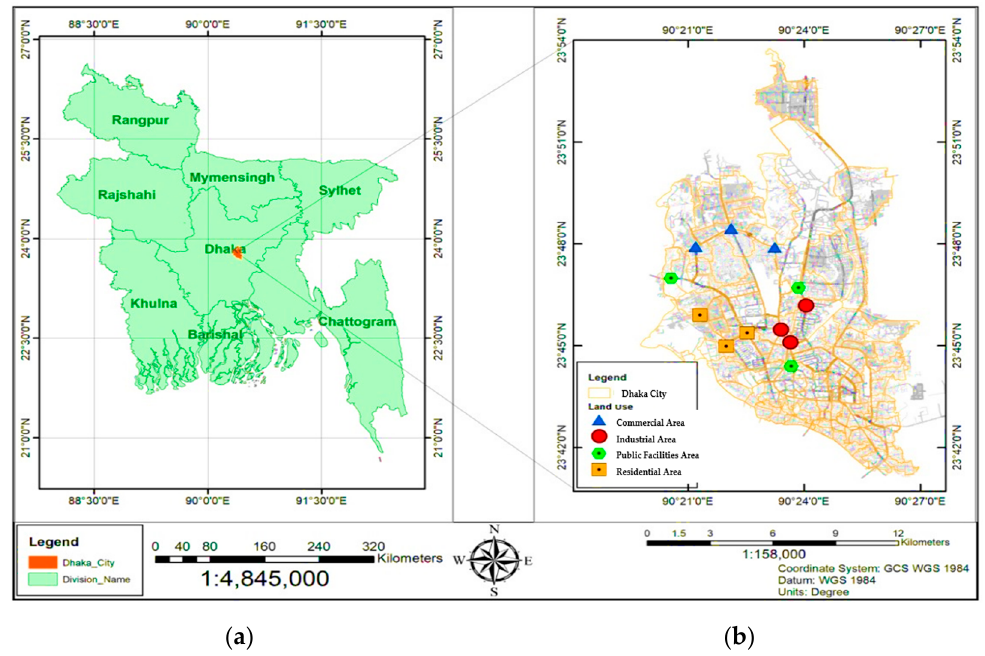
Figure 1. Maps showing the sampling area and study sites [44]. ( a ) The location of the study site (the metropolitan area of Dhaka city; red marked area) in Bangladesh map and ( b ) four different land use categories sampling sites in Dhaka metropolitan